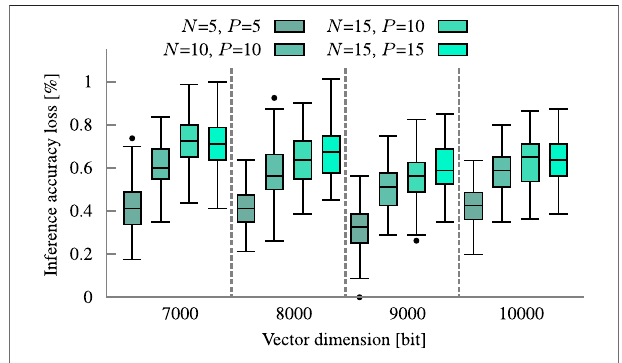
FIGURE12| In fl uenceofblocksizeandprecisiononinferenceaccuracy at the example of the Language. Analysis is done at respective block size ( N ) and precision ( P